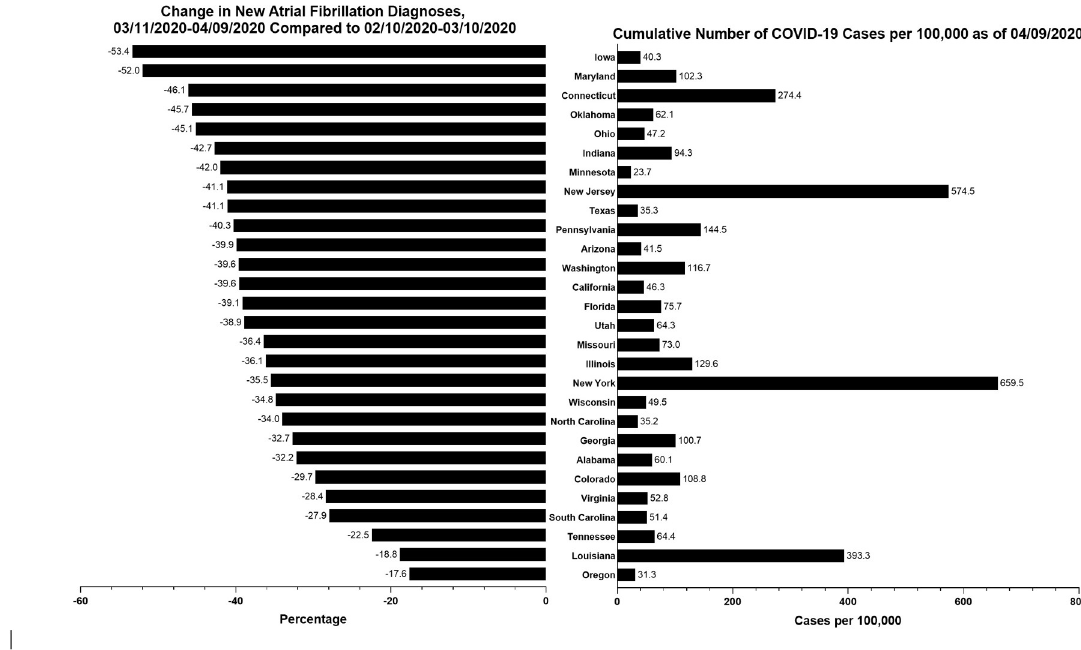
Fig 4. Observed change in new atrial fibrillation diagnoses by